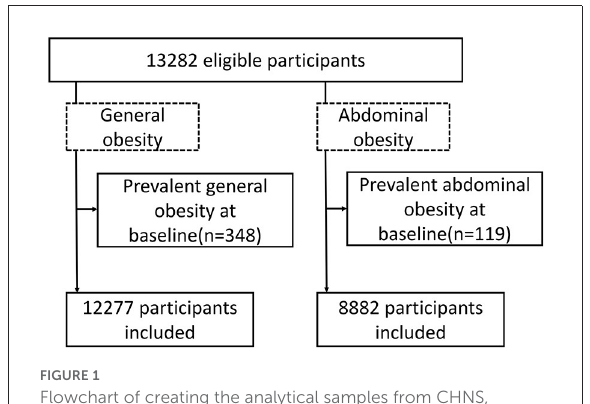
FIGURE1 Flowchart of creating the analytical samples from CHNS,